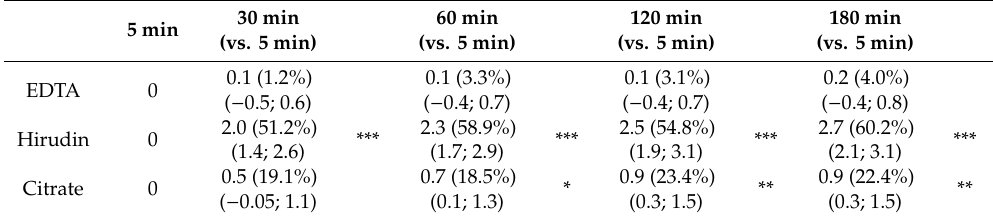
Table 2. Effect of the time elapsed between blood draw and IPF measurement (expressed as the percentage of young platelets to total number of platelets) for each anticoagulant. Measurements at five minutes after blood draw are used as the reference. Mean difference, relative difference (%) and 95% confidence interval for the mean difference are given for each value.